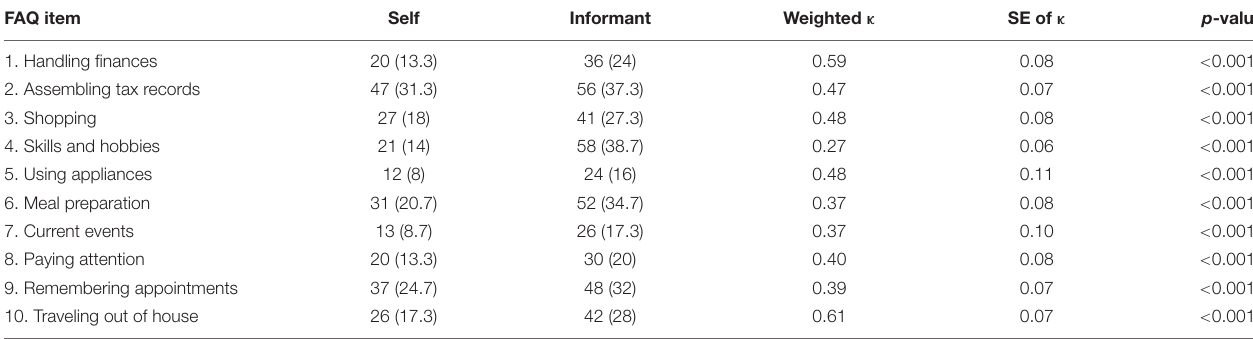
TABLE 2 | Differences between self and informant ratings of the FAQ. FAQ item Self